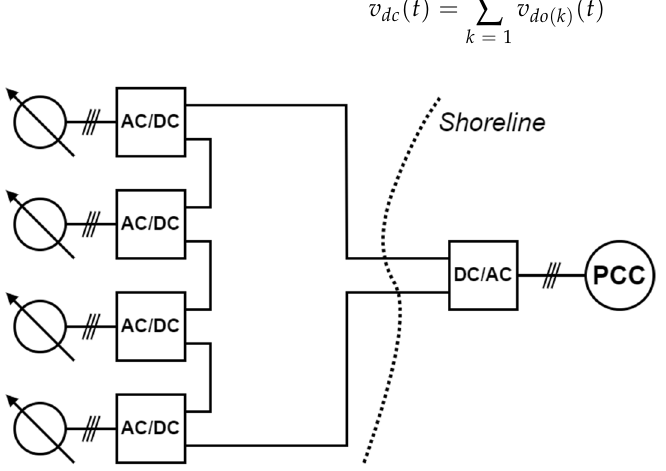
Figure 9. Series DC collection grid.